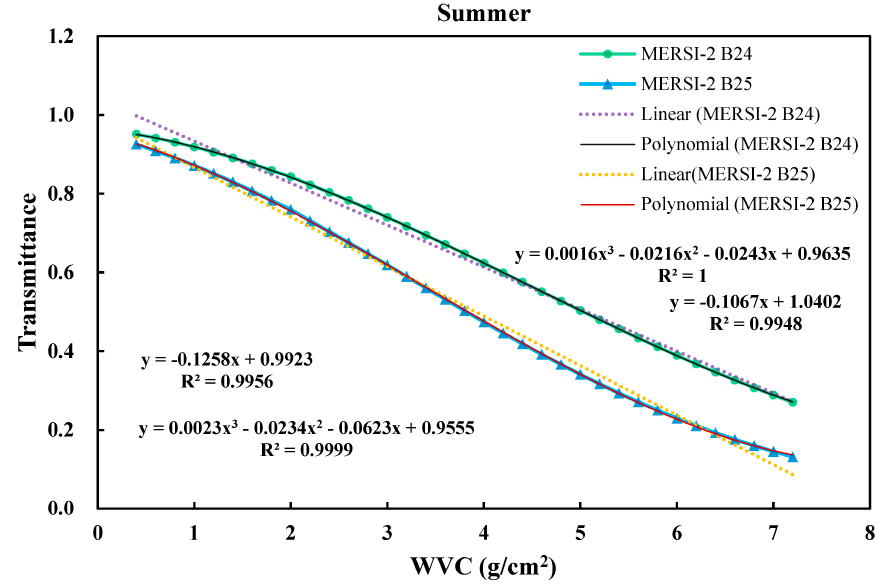
Figure 9. Changes in the atmospheric transmittance of MERSI-2 Band 24 and Band 25 with water vapor content (WVC) (g/cm 2 ) under the summer midlatitude atmospheric conditions.